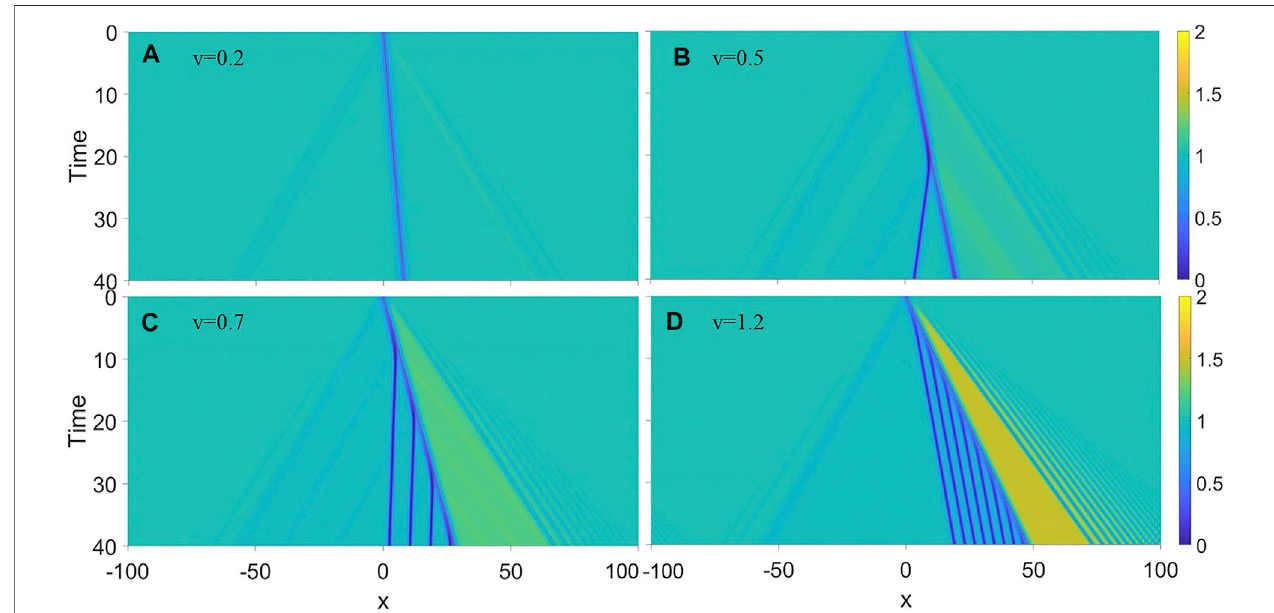
FIGURE 3 | Dependence of solitonic emission on the obstacle speed v for (A) v (cid:2) 0.2, (B) v (cid:2) 0.5, (C) v (cid:2) 0.7, (D) v (cid:2) 1.2, respectively. The parameters take g (cid:2) 2 and A (cid:2) 1.